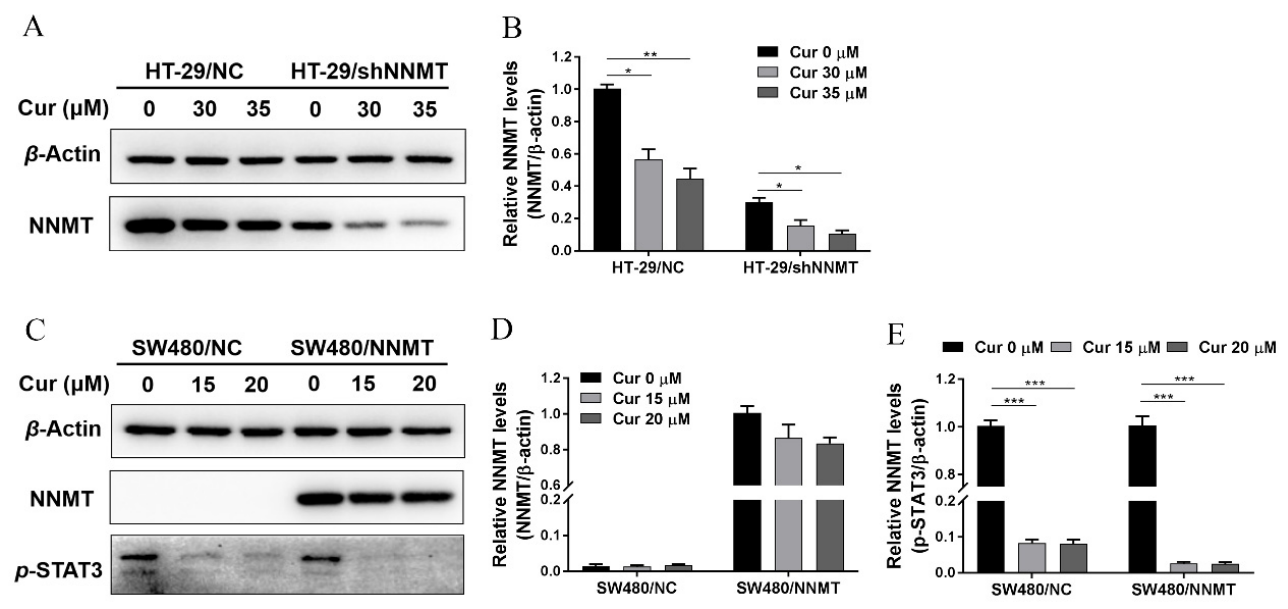
Figure 2. Cur downregulates NNMT and p-STAT3 in CRC cells. ( A , B ) NNMT proteins were determined by Western blot and displayed as a histogram after treatment with Cur for 24 h in HT-29 cells. The untreated group of HT-29/NC was used as the control group, which was set as 1 in the histogram. ( C ) NNMT and p-STAT3 proteins were determined by Western blot after treatment with Cur for 24 h in SW480 cells. ( D ) NNMT proteins were displayed as a histogram after treatment with Cur for 24 h in SW480 cells. The untreated group of SW480/NNMT was used as the control group, which was set as 1 in the histogram. ( E ) p-STAT3 proteins were displayed as a histogram after treatment with Cur for 24 h in SW480 cells. The untreated group of SW480/NC was used as the control group, which was set as 1 in the histogram. Cur: curcumin. Data are expressed as means ± SD, n = 3, * p < 0.05, ** p < 0.01, *** p < 0.001.